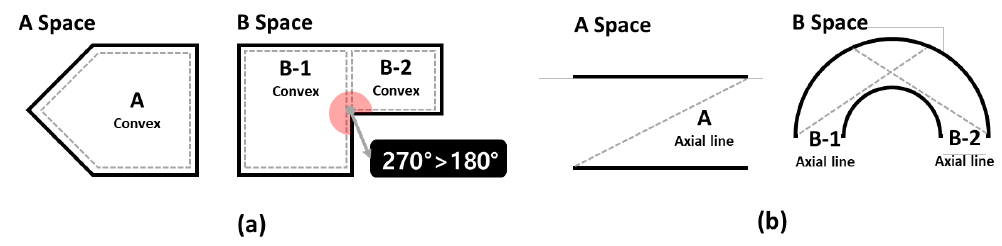
Figure 2. Design of spatial analysis form: ( a ) Convex space; ( b ) Axial map. Table 1. Key analysis indicators for axial